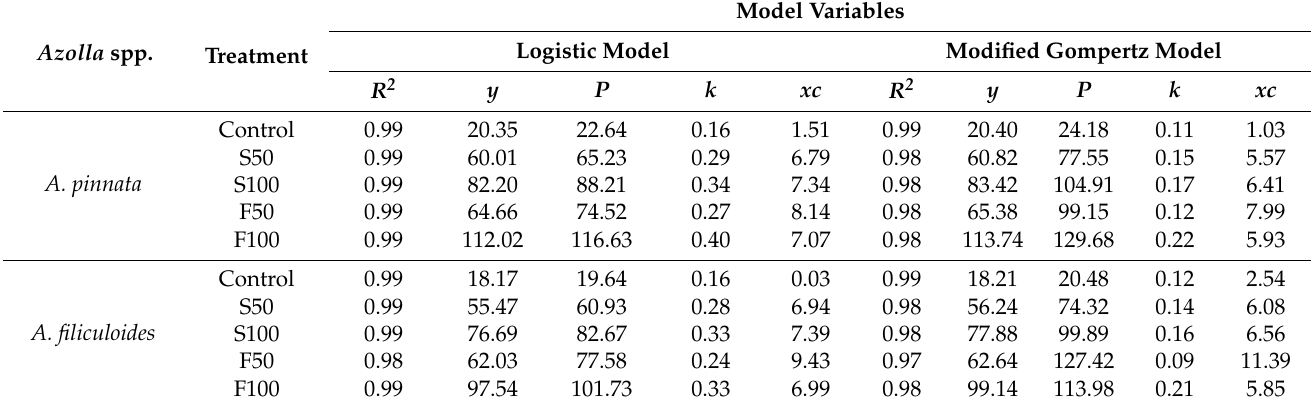
Table 4. Comparative assessment of growth kinetic models two Azolla spp. cultivated in different treatments of